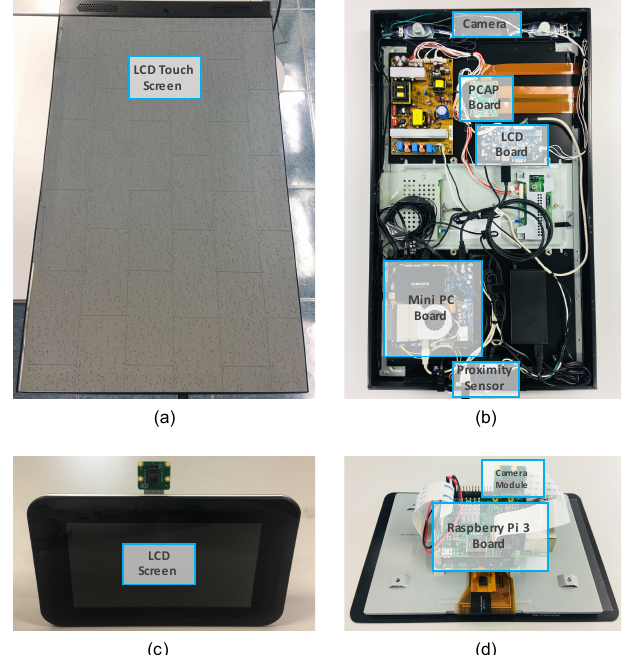
Figure 5. Hardware components of the prototype with a smart mirror and a smart doorbell; ( a ) the external view of the smart mirror, ( b ) the internal view of the smart mirror, ( c ) the external view of the smart doorbell, and ( d ) the internal view of the smart